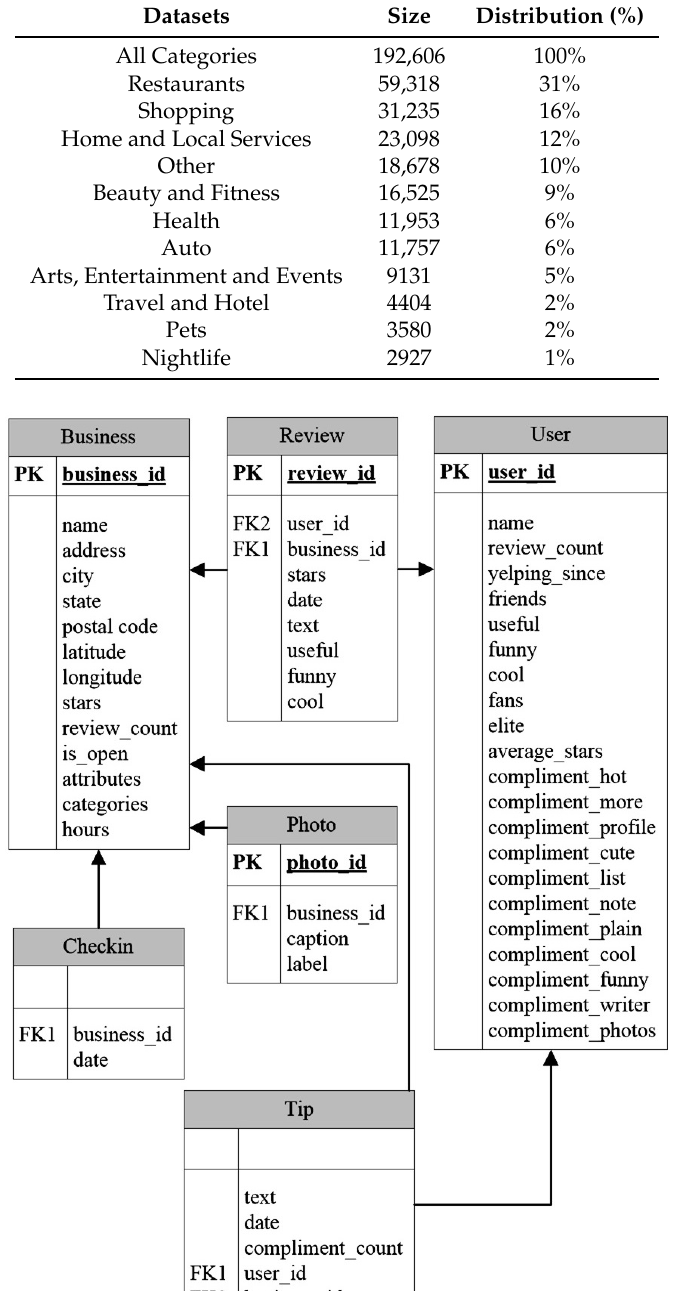
Figure 2. Entity relationship diagram of Yelp